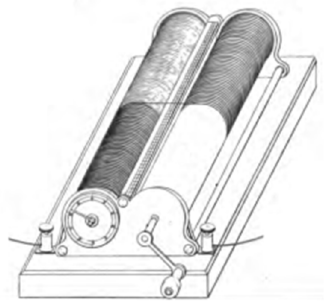
Figure 2. Charles Wheatstone’s rheostat